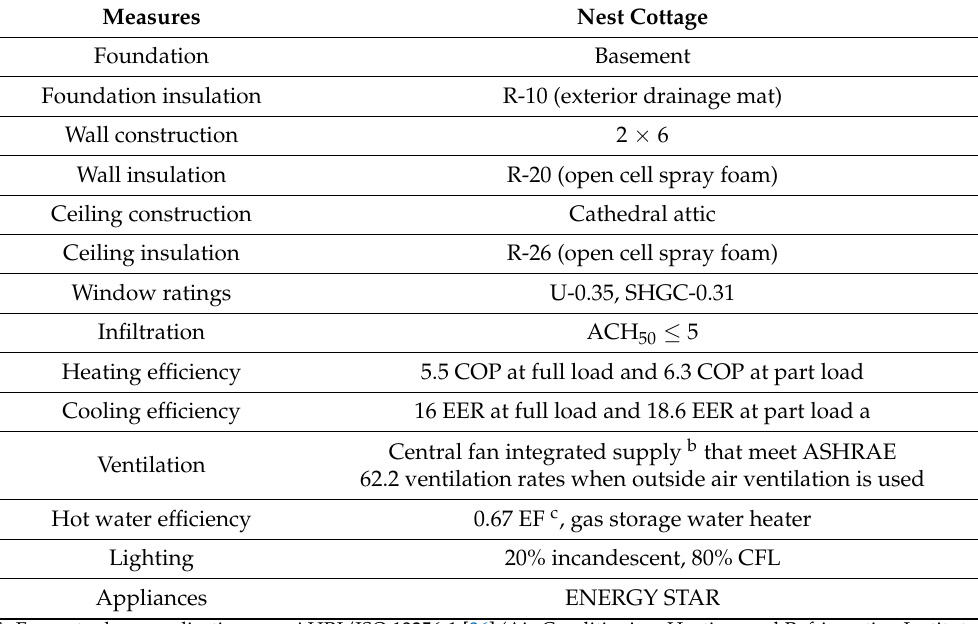
Table 4. Building A (Nest Cottage) Specifications. Data from Butler et al. [36].